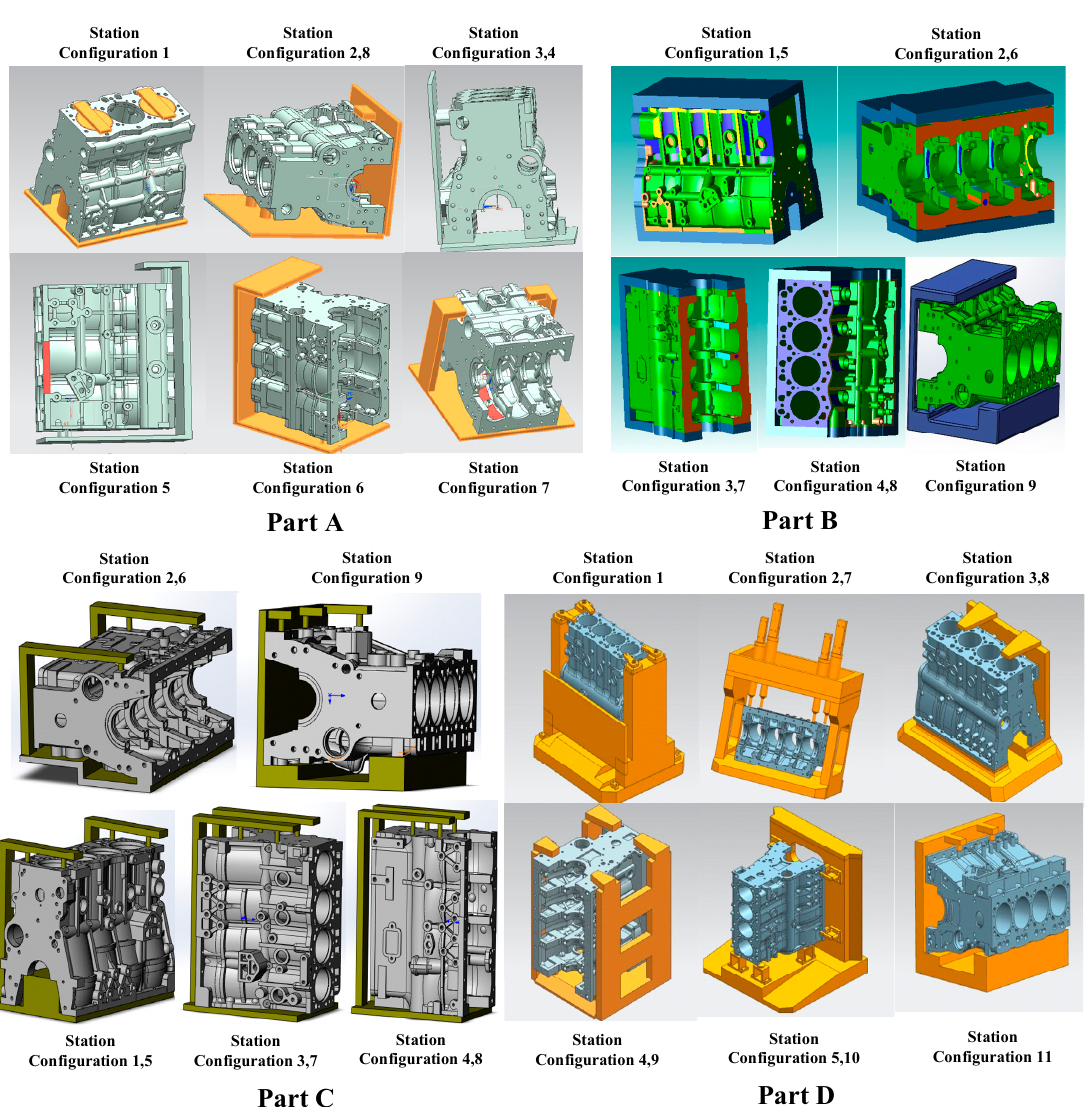
Figure 6. Possible fixture devices and part orientations for the four